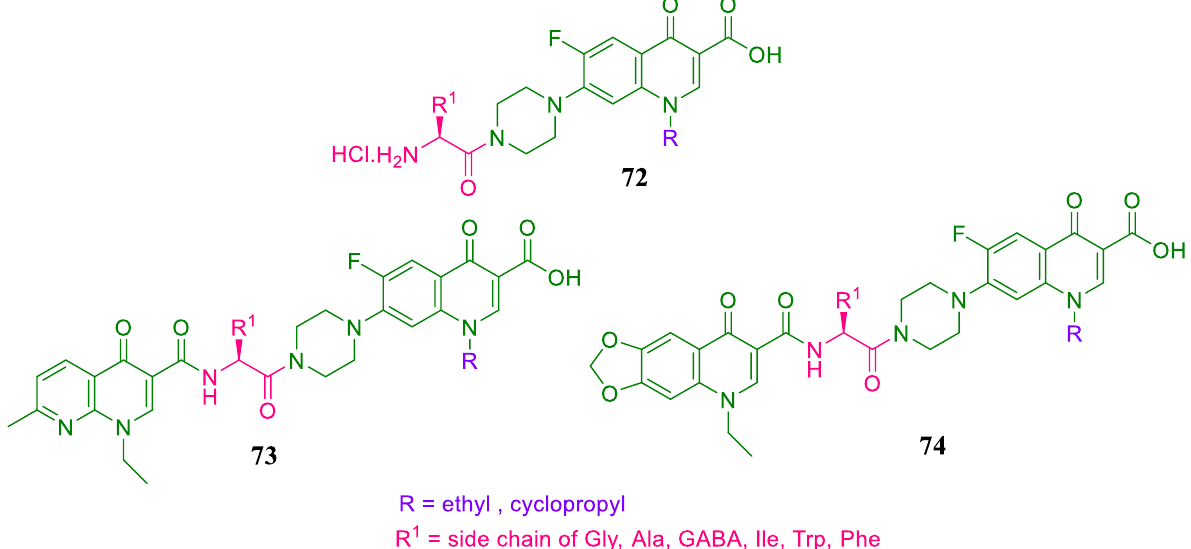
Figure 60. Amino acids conjugated to fluoroquinolone-quinolone.